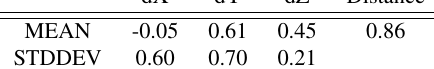
Figure 5: Inside view of the constructed point cloud model ated effectively and accurately even in featureless areas. Exper- iment results indicate that the distance error of the constructed merge point clouds is less than 2 centimeters using the proposed processing procedure. This process will be an effective approach to build an indoor mapping